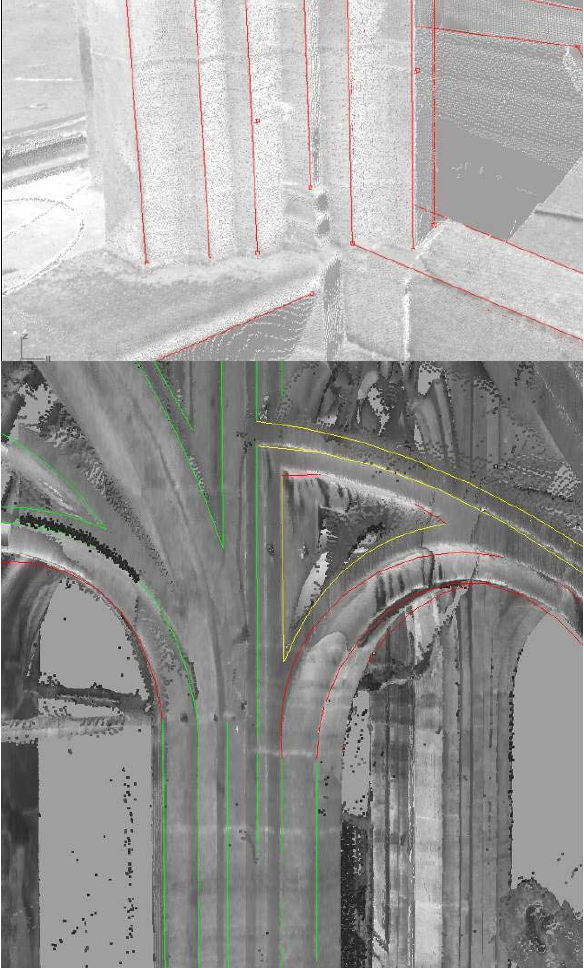
Figure 7: Reconstruction of columns and subdivision into their constructive marble blocks. Block break-lines and corner lines are extracted photogrammetrically. Model refining and completion is done with support of a laser scan point cloud.